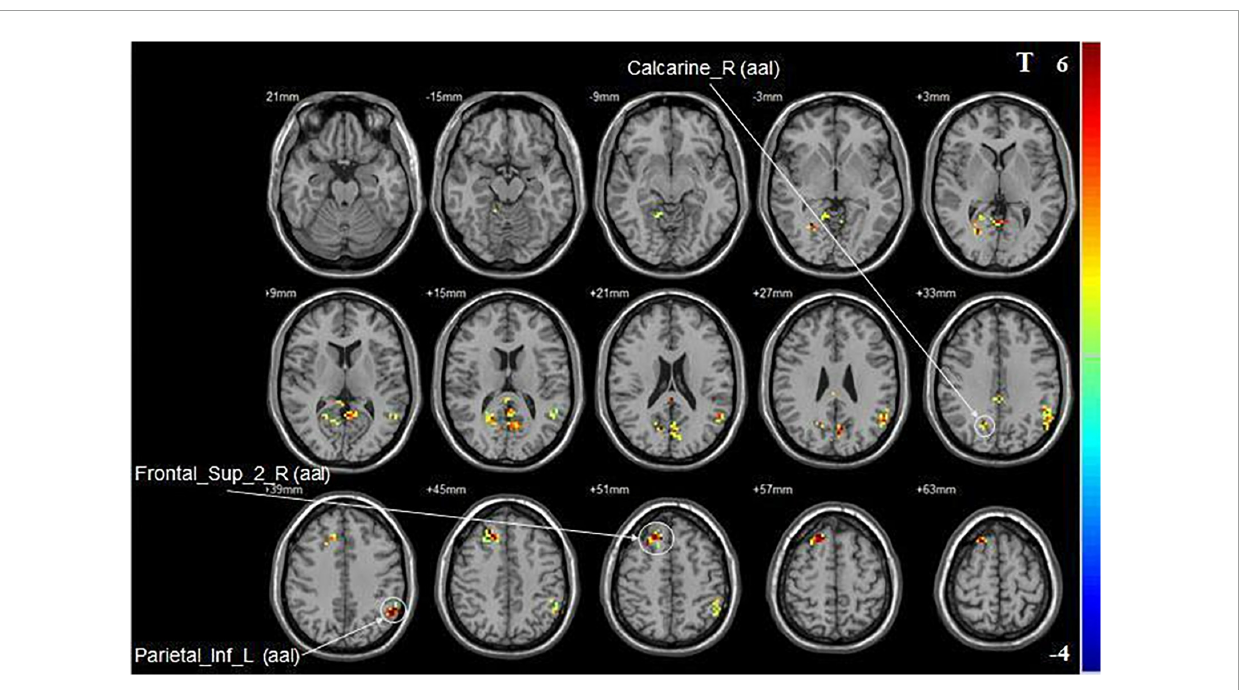
FIGURE3 Statistical maps showing fALFF change pre- and post-iTBS in the non-dominant cerebellum group. Warm colors showing fALFF increased and cool colors showing fALFF decreased after iTBS.